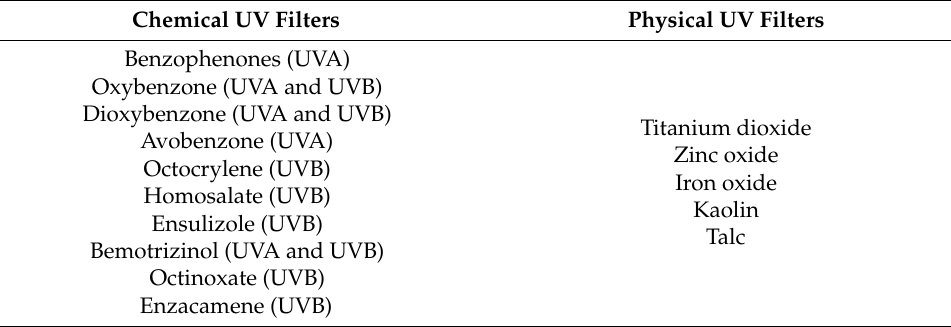
Table 1. Examples of UV filters used in sunscreen formulations